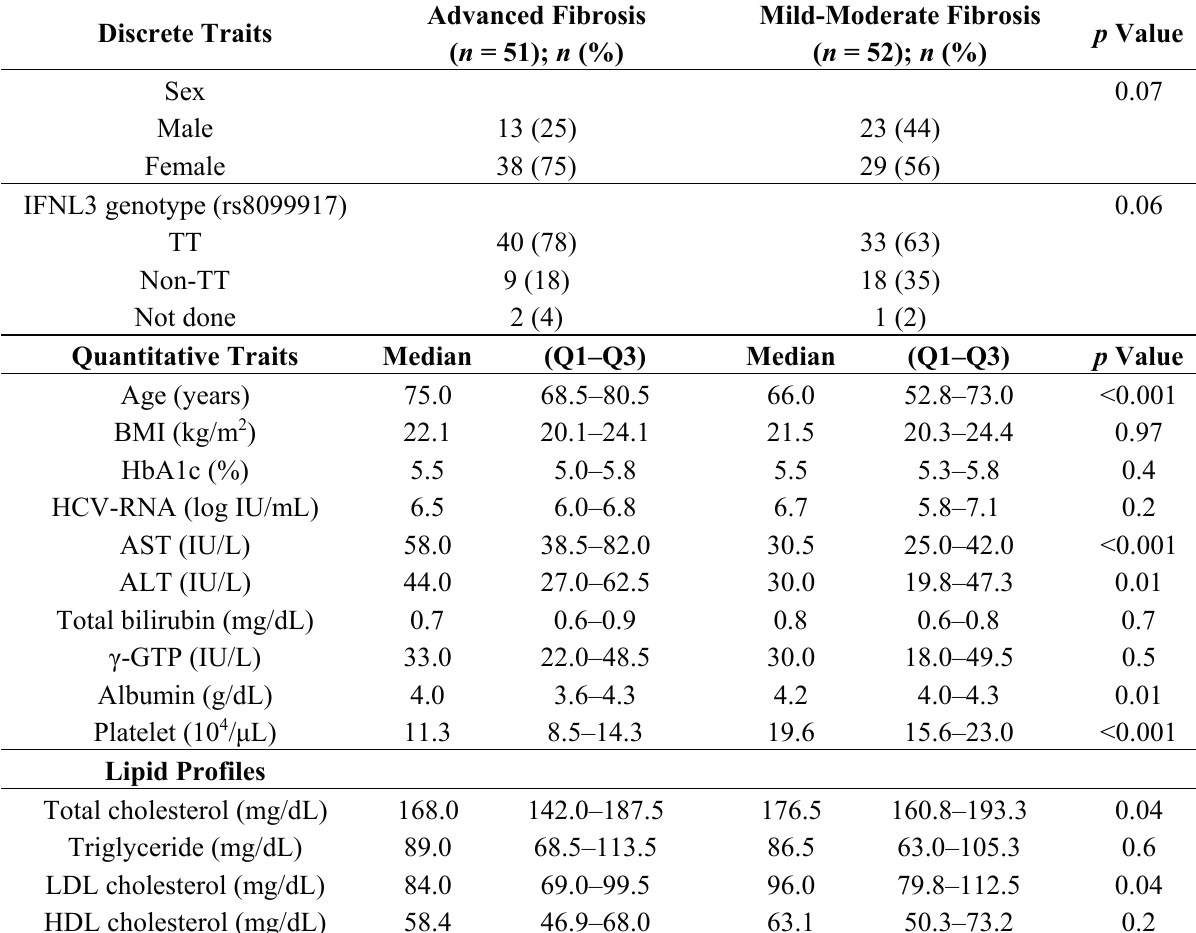
Table 4. Comparison of clinical features and the interferon lambda (IFNL) 3 genotype between HCV G1b patients with advanced fibrosis and those with mild-moderate